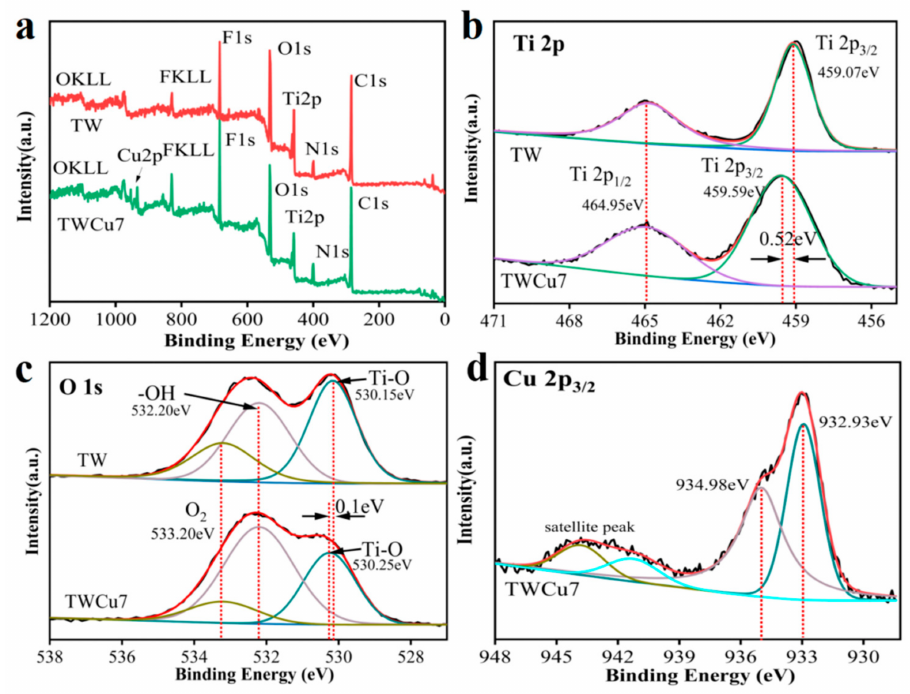
Figure 3. ( a ) XPS spectra of survey scan and XPS high-resolution spectra of ( b ) Ti 2p, ( c ) O 1s, and ( d ) Cu 2p 3/2